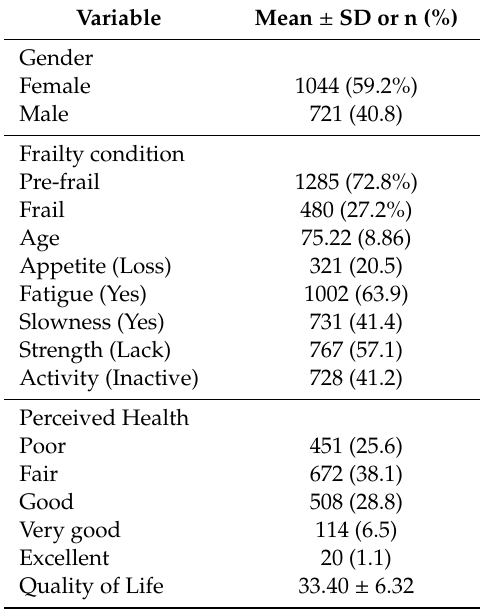
Table 1. Descriptive statistics of the categorical variables involved in the